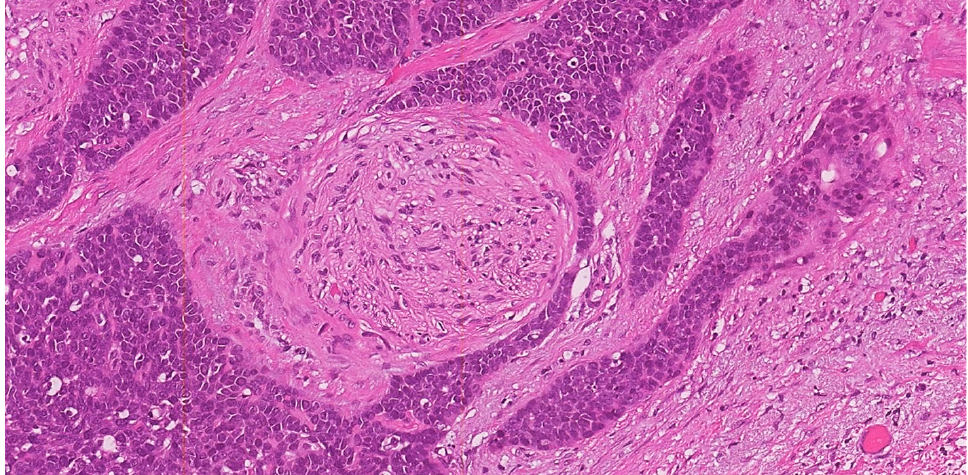
Figure 2. H&E stained section (10 × ) illustrating perineural invasion. In this example of squamous cell carcinoma of the uterine cervix with basaloid morphology, a small round nerve structure (center of the field) is surrounded by the neoplastic proliferation ( ×